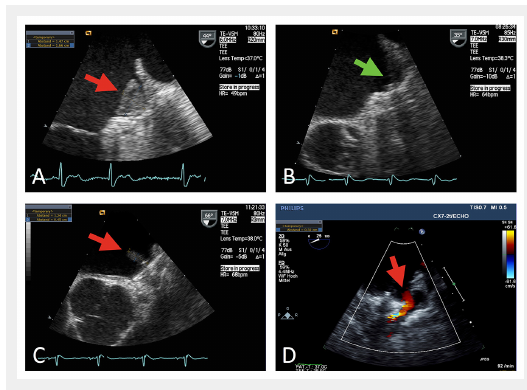
Examples of procedure-related adverse findings in the TOE follow- up 4 months after LAAC. The red arrow in panel A shows a device-adherent thrombus of 15 x 17 mm. After resumption of OAC, the thrombus had dissolved without clinical sequelae after 3 months (panel B, green arrow pointing on device surface). In panel C, the red arrow